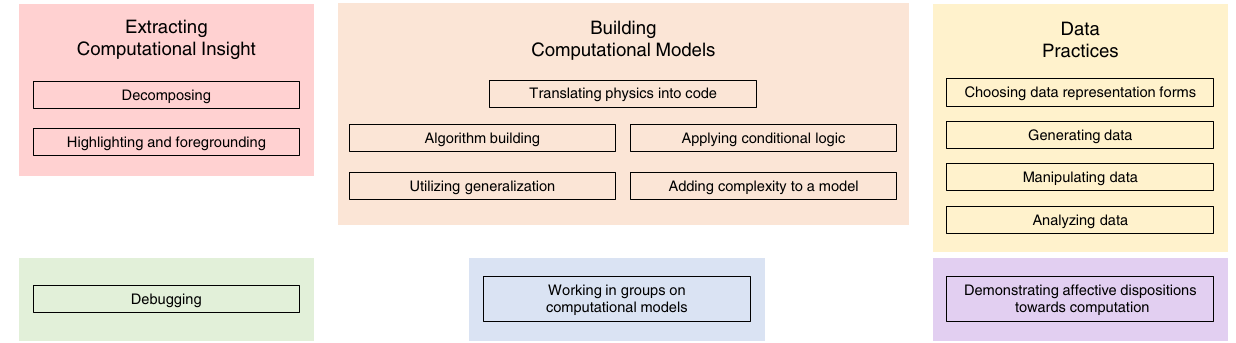
FIG. 2. Outline of the practices in our computational thinking framework. The framework has 14 practices comprising 6 distinct categories. The categories of extracting computational insight, building computational models, and data practices all contain several practices within them. The categories of debugging, demonstrating dispositions towards computation, and working in groups on computational models exist as standalone